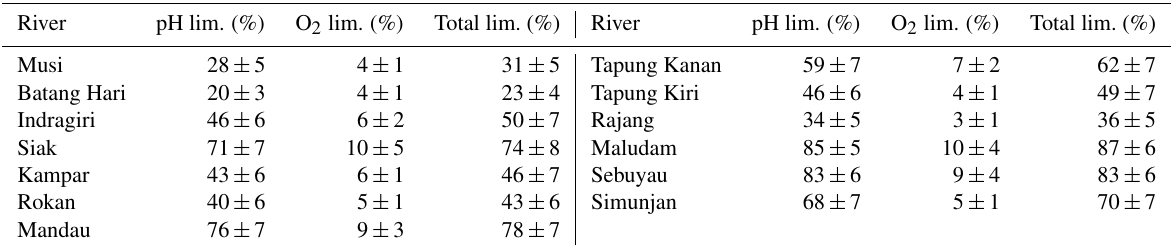
Table A4. pH and O 2 limitations in the individual rivers based on exponential pH